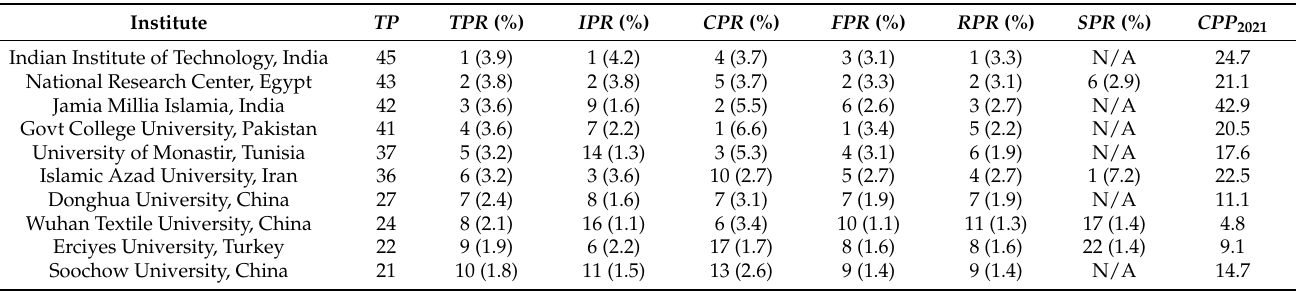
Table 4. Top 10 productive